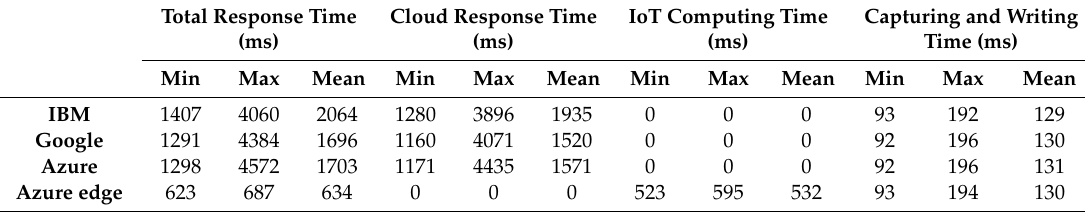
Table 2. Latency measurement in di ff erent platforms.